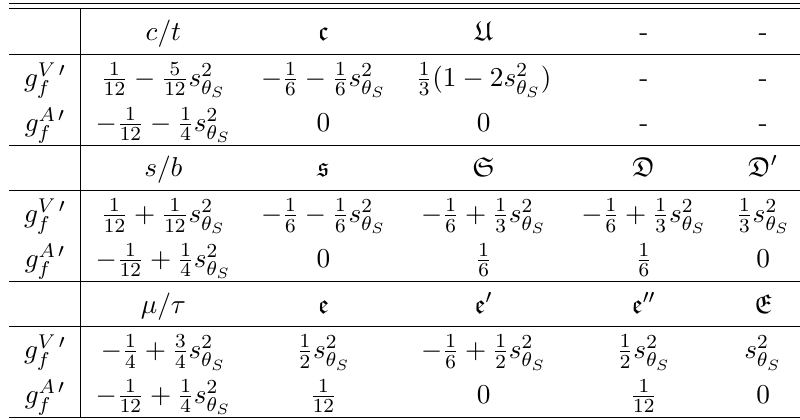
Table 11 . The couplings of the flavor-conserving neutral currents mediated by Z 0 basis, with θ being the SU(3) U(1) mixing angle defined in eq. (5.16). S W ⊗ X 1 embedding of multiple SM generations requires at least rank- 3 (or above) anti-symmetric irreps that are not self-conjugate. One should also expect the flavor non-universality in a realistic non-minimal GUT from its extended weak and strong